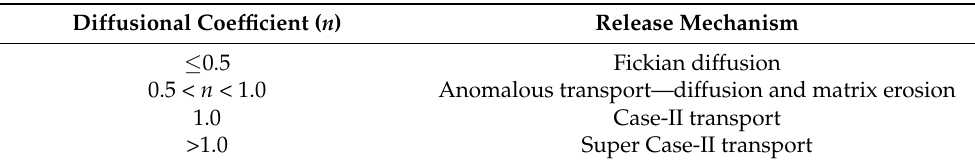
Table 1. Release mechanism interpretation of the diffusional coefficient of the Korsmeyer–Peppas model for a polymeric film